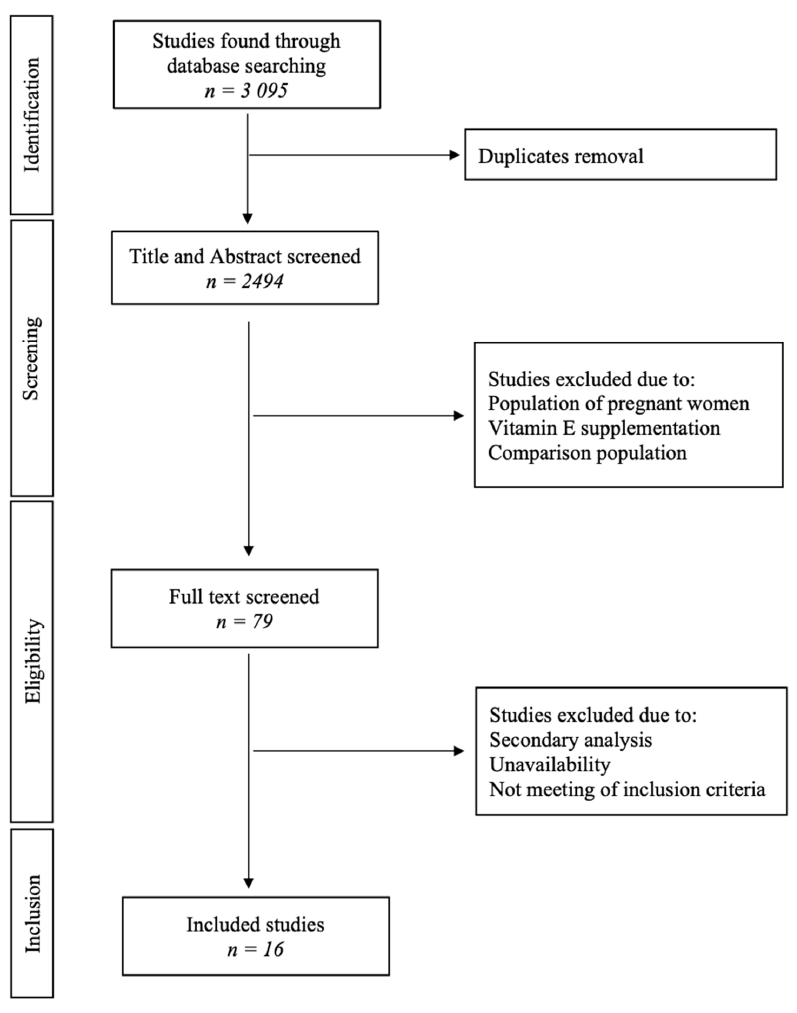
Figure 1. PRISMA systematic review flow diagram.